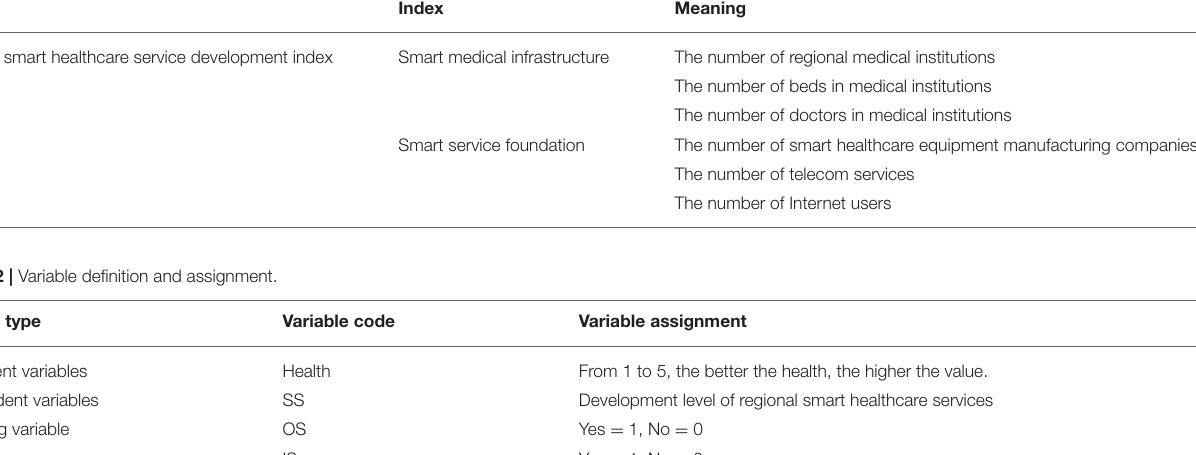
TABLE 1 | Regional smart healthcare service development index.